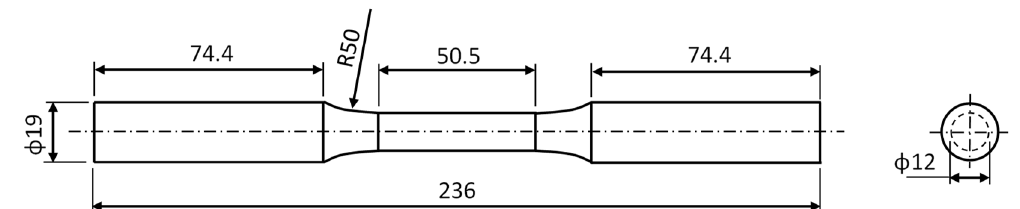
Figure 3. Fatigue test specimen dimensions.